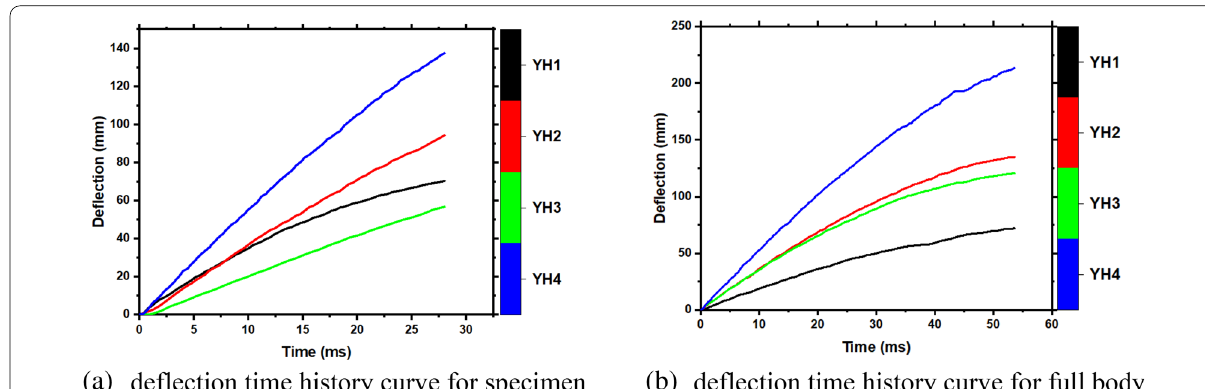
Fig. 14 Deflection time history curve.